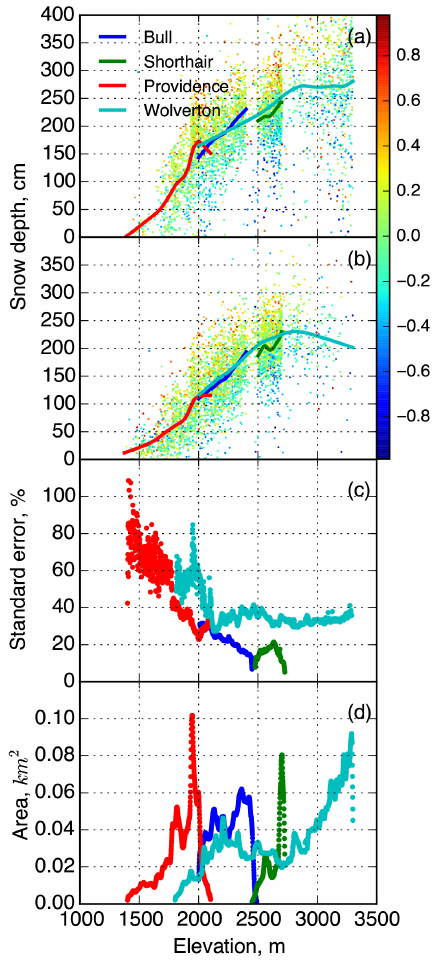
Figure 6. LOESS-smoothed snow depth with northness color-coded scatterplot of raw-pixel snow depth against elevation for (a) open and (b) under-canopy areas. (c) Standard error of the snow depth within each 1m elevation band for open area. (d) Total area of each elevation band for both open and under-canopy areas. Values above 3300m are not shown, where there are few